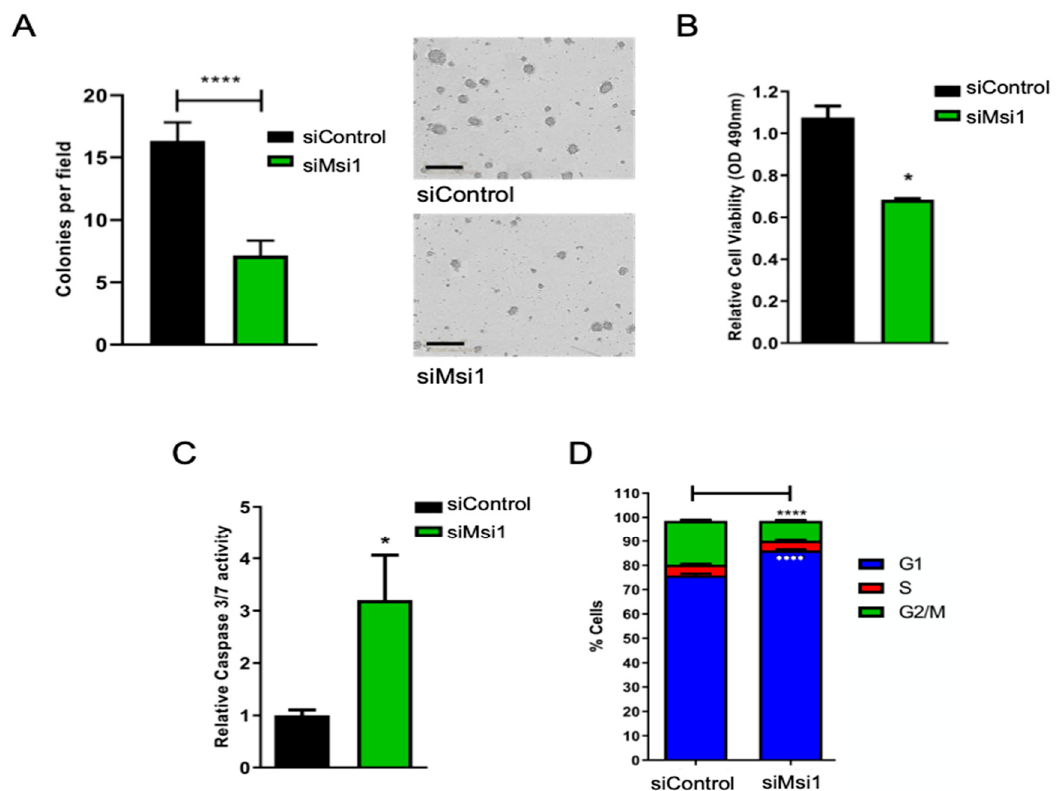
Figure 2. Musashi1 knockdown affects cancer ‐ related phenotypes in CHLA ‐ 01R cells . ( A ) Effect of Msi1 knockdown on cell growth (A), cell viability according to the MTS assay ( B ), apoptosis verified by caspase assay ( C ) and cell cycle distribution shown in FACS ‐ sorted cells ( D ). Statistical significance calculated by one ‐ way ANOVA and t test. Data shown as means ± S.D. (* p < 0.05, **** p < 0.0001).